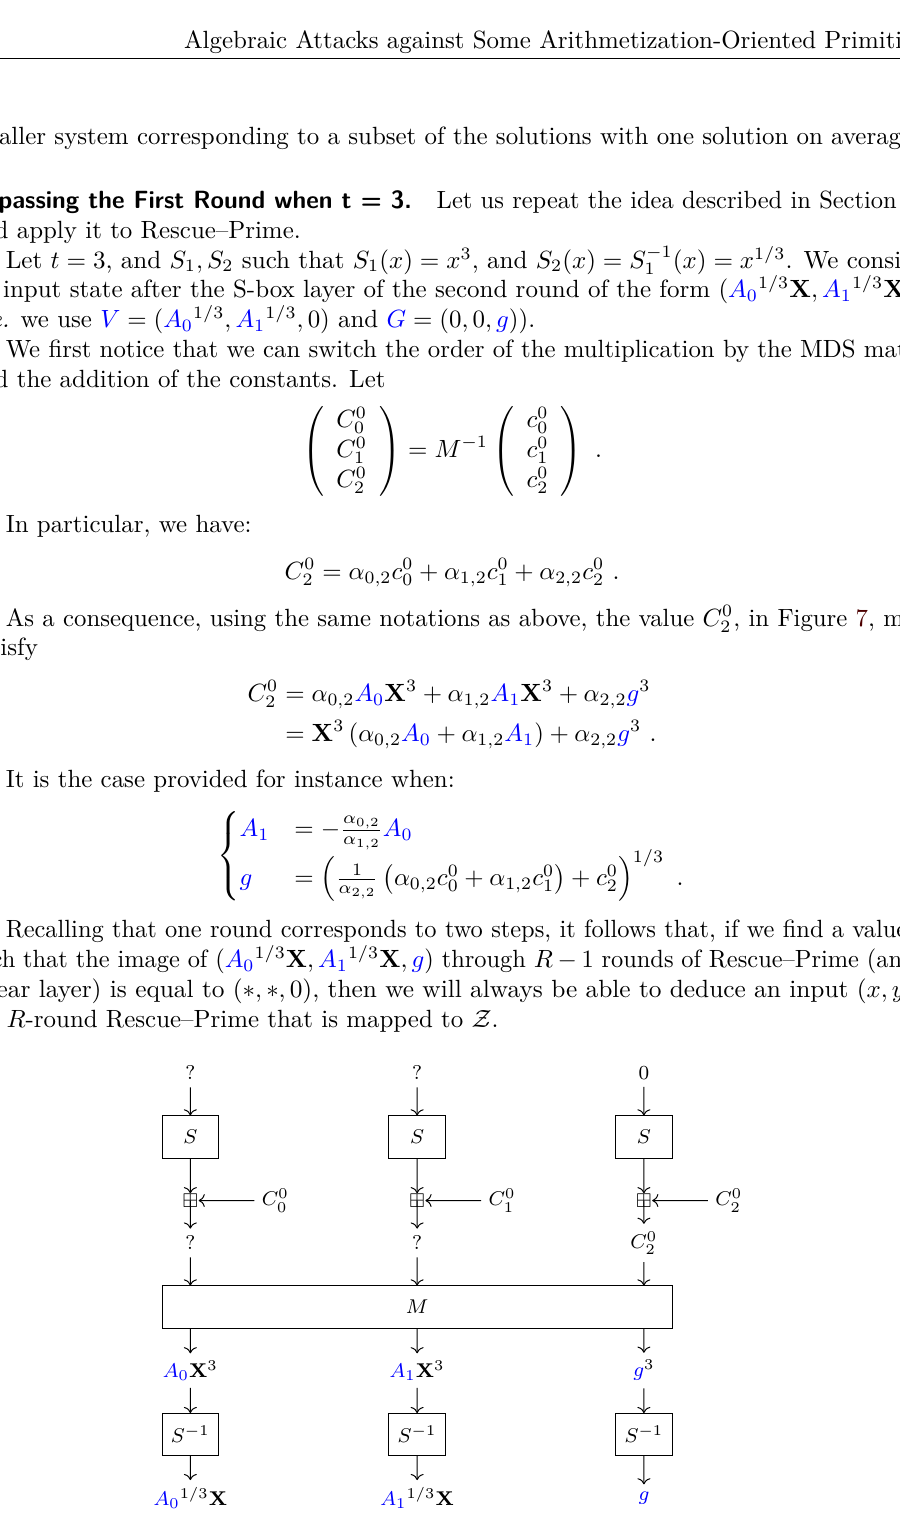
Figure 7: How to bypass the first round of